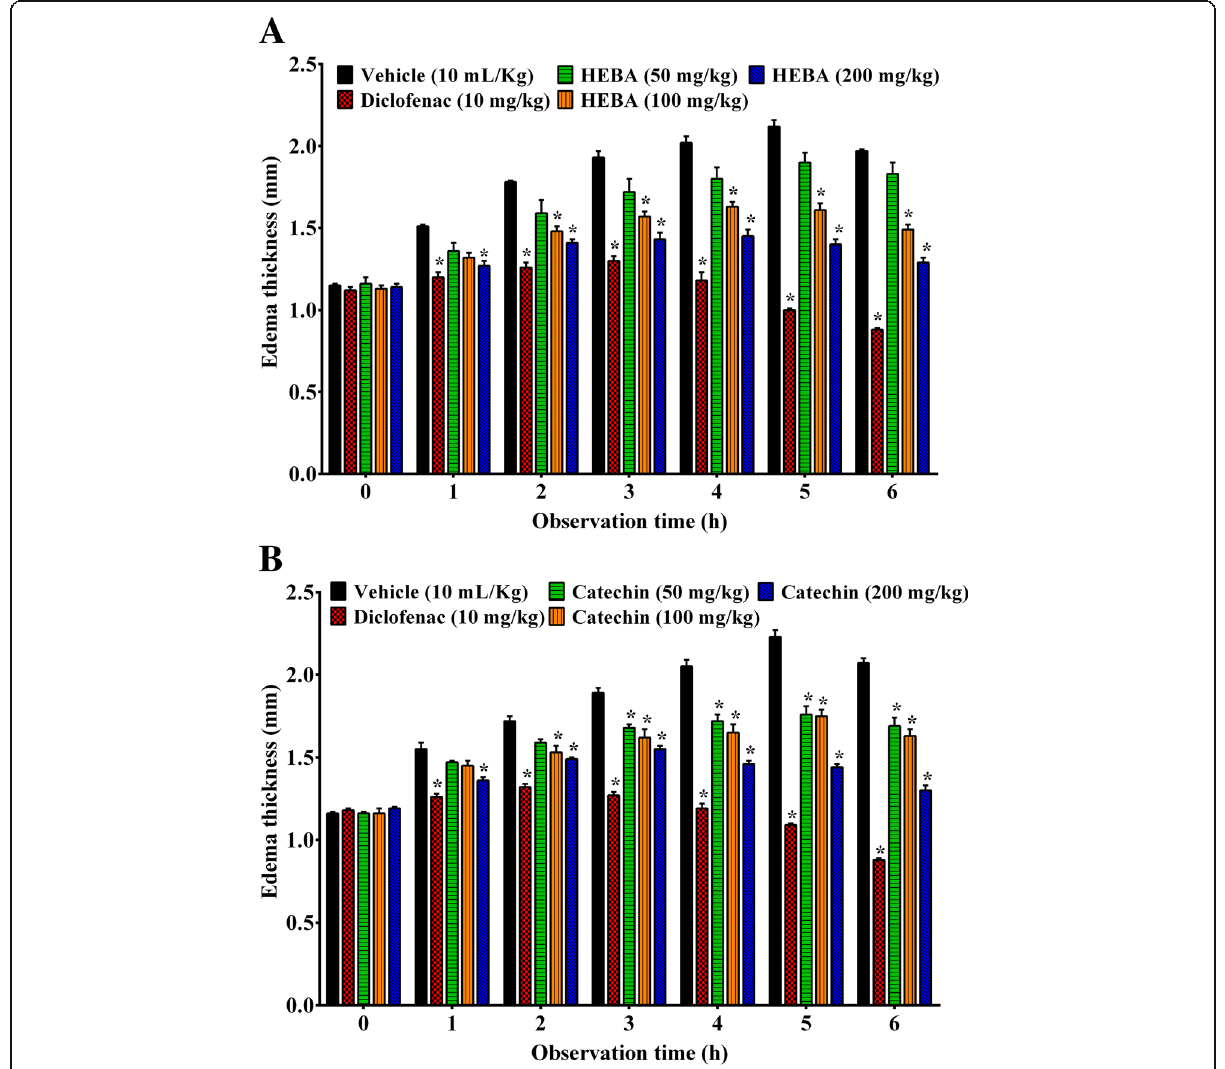
Fig. 6 Effect of diclofenac, HEBA (panel a ) and (+)-catechin (panel b ) treatments on paw edema at multiple time interval in carrageenan-induced paw edema test. Data are presented as mean ± SEM ( n = 5). * represents p < 0.001, compared to control group mice. HEBA = hydro-methanolic extract of the bark of A.